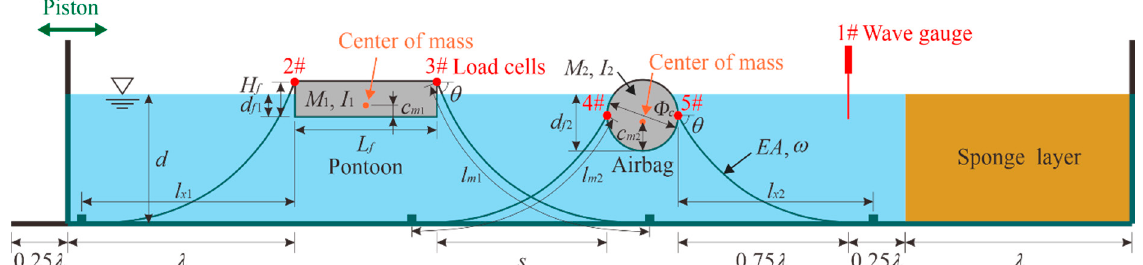
Figure 12. Numerical wave flume used to simulate the interaction between waves and a pontoon-airbag double-row floating breakwater.